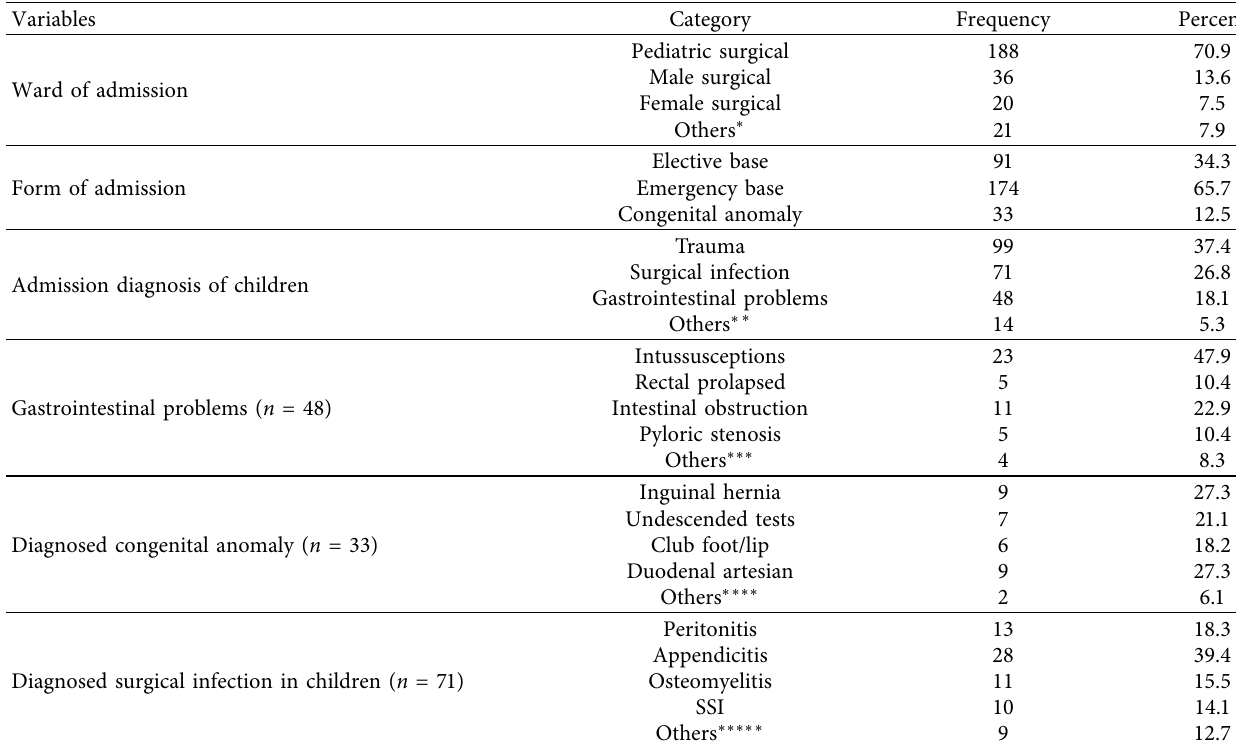
Figure 1: Type of trauma among pediatric surgical patients admitted to Arbaminch General Hospital from January 1, 2017, to December 31, 2020 ( n � 265). Table 2: Causes and forms of pediatric surgical patient’s admission to Arbaminch General Hospital from January 1, 2017, to December 31, 2020 ( n �